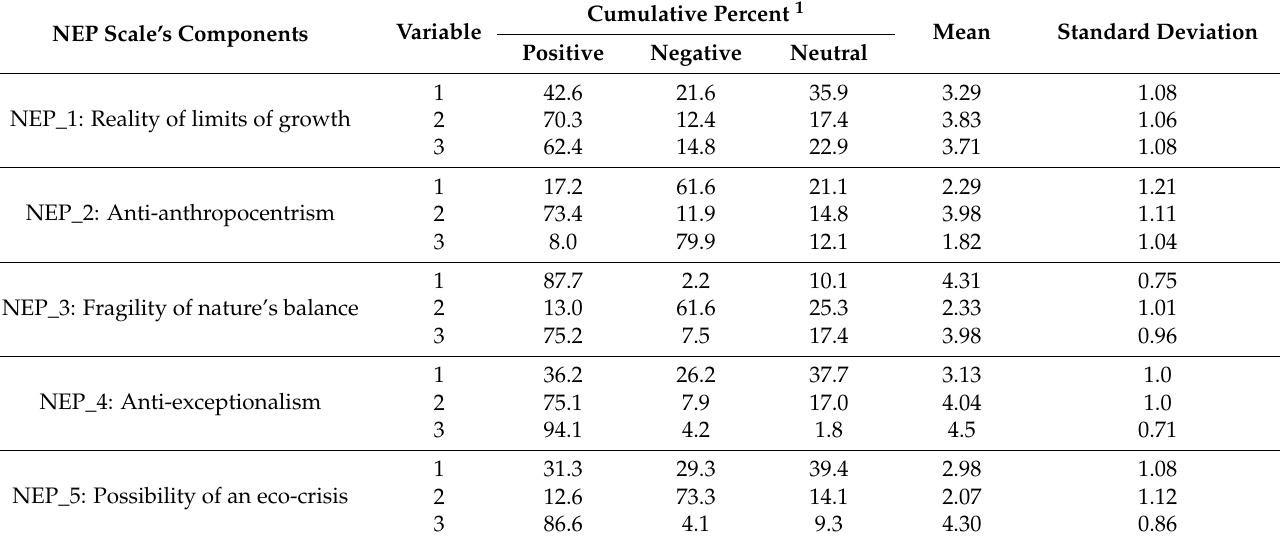
Table 3. Responses concerning the NEP